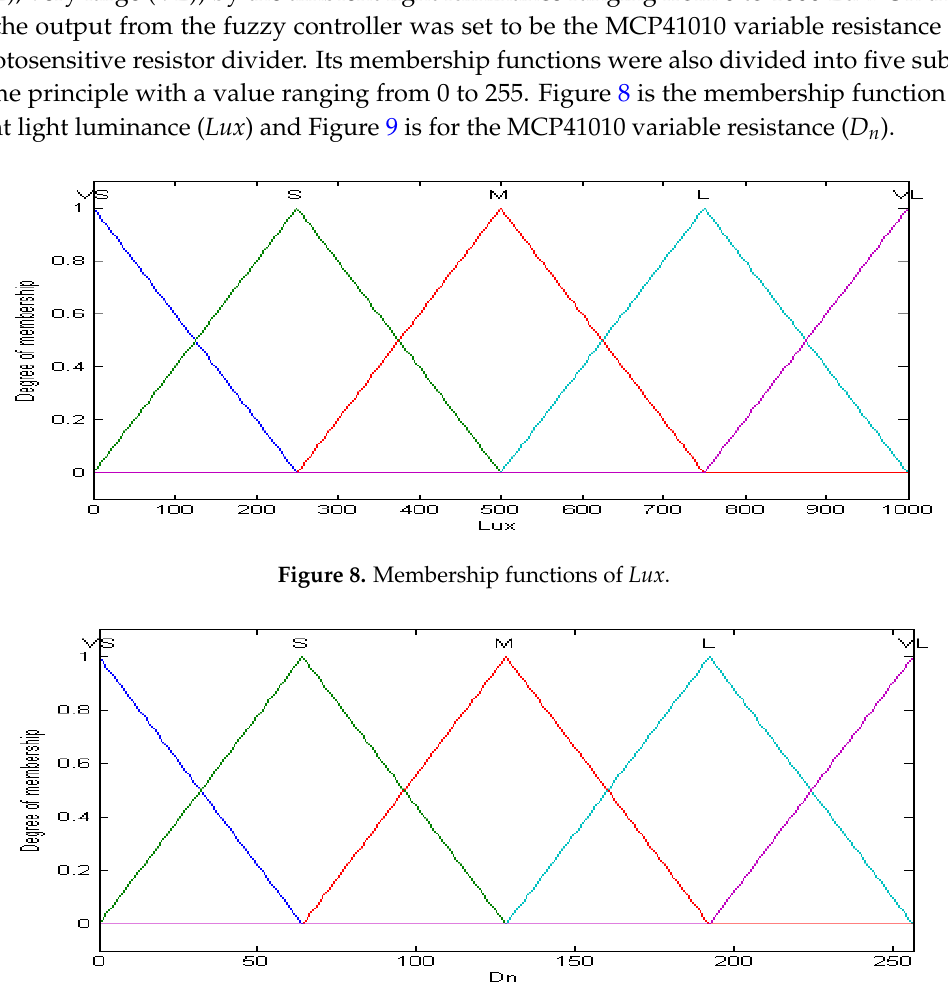
Figure 9. Membership functions of 𝐷 𝑛 .